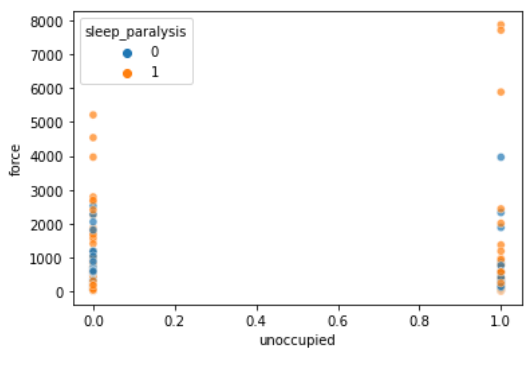
Figure 12. Unoccupied Face vs Sleep Paralysis